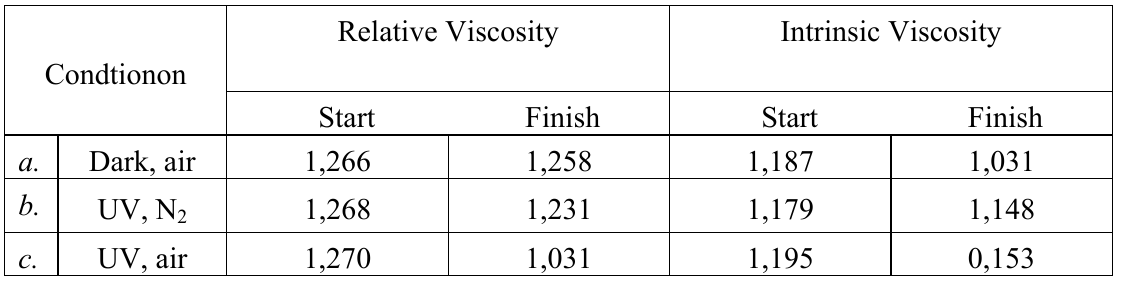
Table 1. The effect of UV light on cellulose nitrate